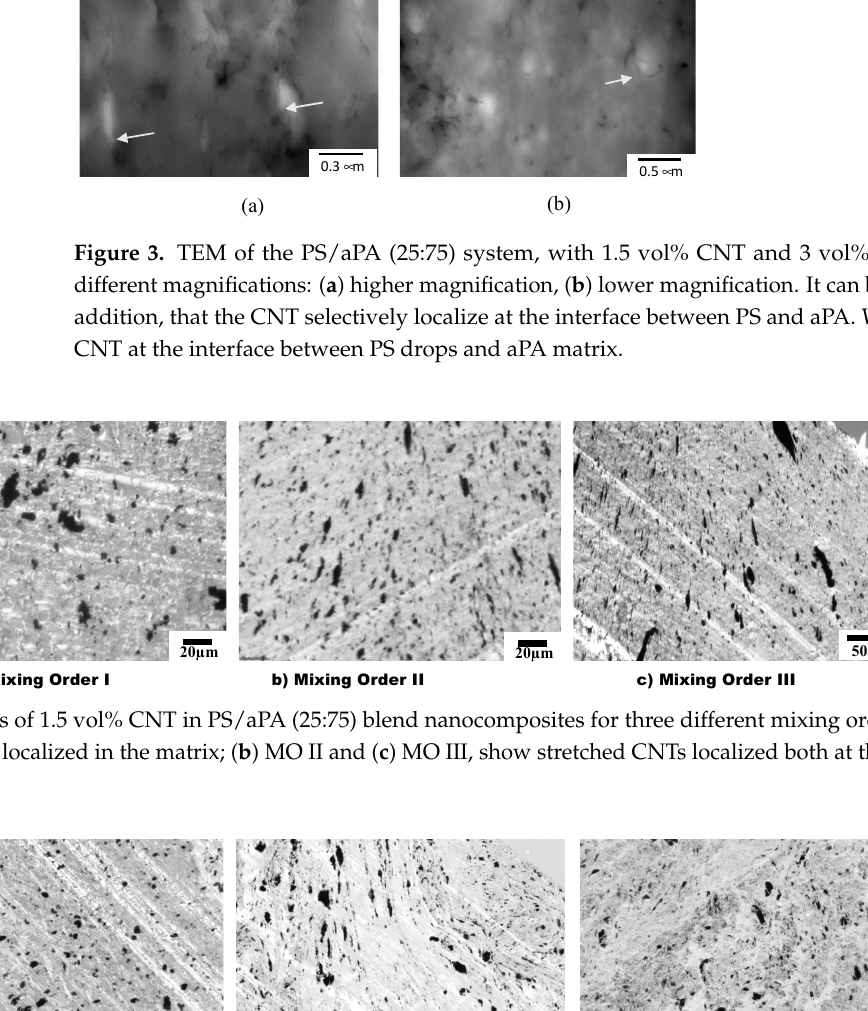
Figure 4. OM images of 1.5vol % CNT in PS/aPA (25:75) blend nanocomposites for three different mixing orders.